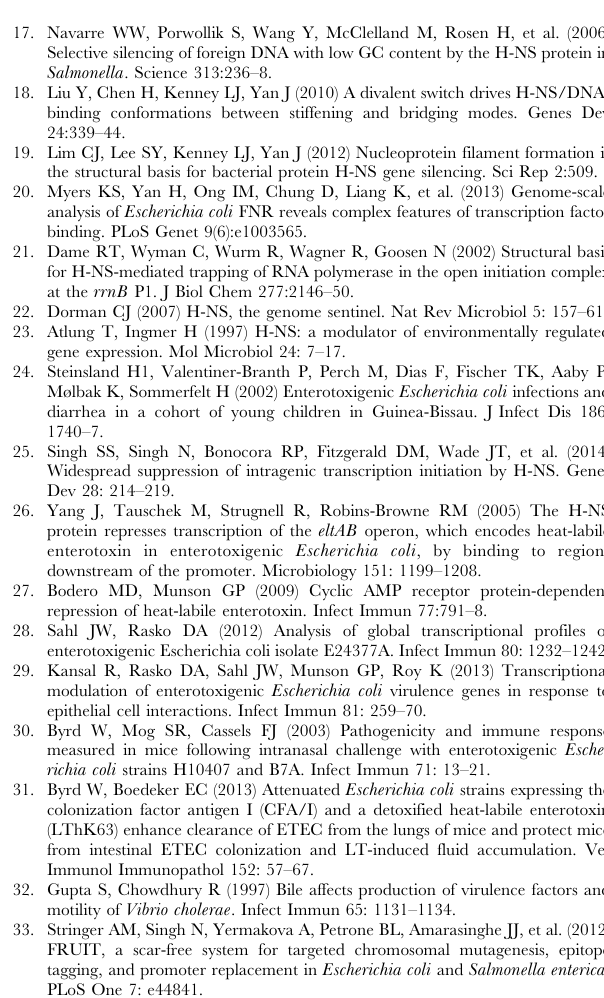
S3 Fig A) Mutations in P estA2 UP-element alter the migration of the promoter DNA on an agarose gel. The DNA sequences used are shown in part (i) and the mobility of the fragments, on an agarose gel, are shown in part (ii). Note that each sample has been loaded in duplicate. B) Mutating the UP-element renders P estA2 uninducible by CRP. Part (i) shows LacZ activity data for the different promoter fragments cloned in pRW50. The pRW50 derivatives were used to transform M182 or the D crp derivative. Part (ii) shows the result of in vitro transcription assays using the different promoter fragments, cloned in pSR, as a template. S4 Fig Activity of different promoter:: lacZ fusions in the presence of increasing glucose and salt concentra- tions. The figure shows b -galactosidase activity measurements for lysates obtained from cultures of M182 carrying the A) estA1 B) estA2 or C) eltAB promoters cloned in pRW50. Panel D) shows b - galactosidase activity values for lysates of M182 and M182 D hns cells, carrying the estA2 promoter, or a derivative lacking the CRP site, cloned in pRW50. Cells were grown in the presence or absence of 2% glucose. Assays were done in M9 minimal medium so that the glucose and salt concentrations could be more accurately controlled.